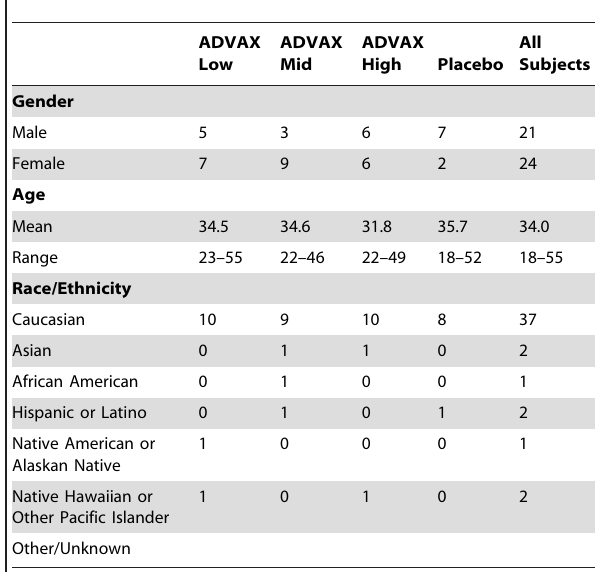
Table 2. Baseline Demographics.